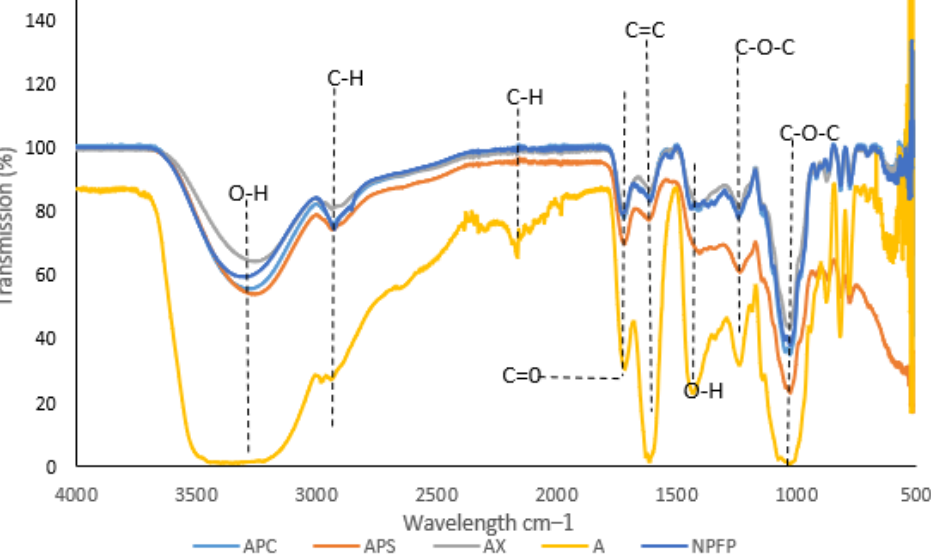
Figure 4. Fourier transform infrared spectroscopy measurements (FT-IR) of A-alginate, APS-alginate: psyllium mucilage, AX-alginate: xanthan gum, APC-alginate: pectin beads and NPFP-Natal plum powder .